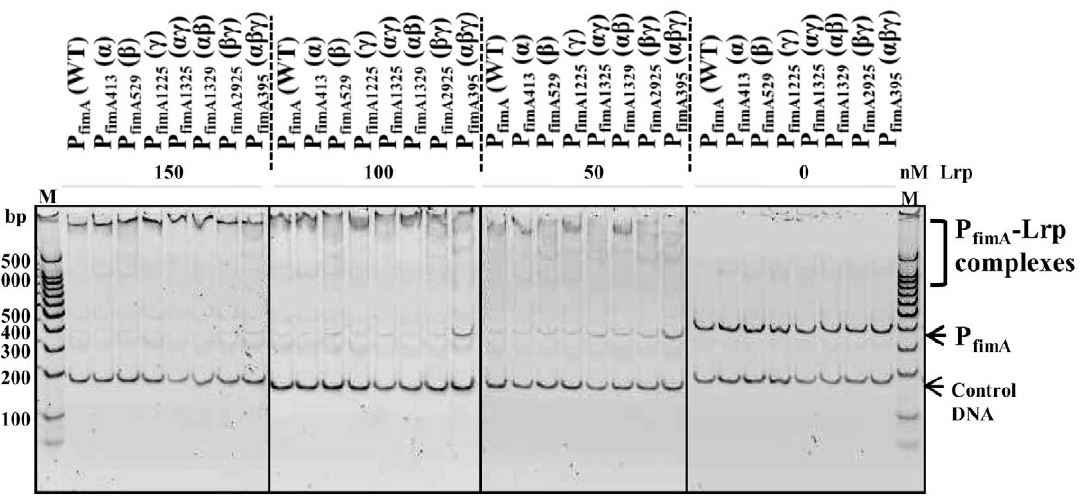
Figure 5. Effects of Lrp-binding motif mutations in P fimA by EMSA. Lrp was added at 150, 100, 50, and 0 nM. Reaction products were separated in a 5% polyacrylamide gel. Data presented are representative of two independent observations.